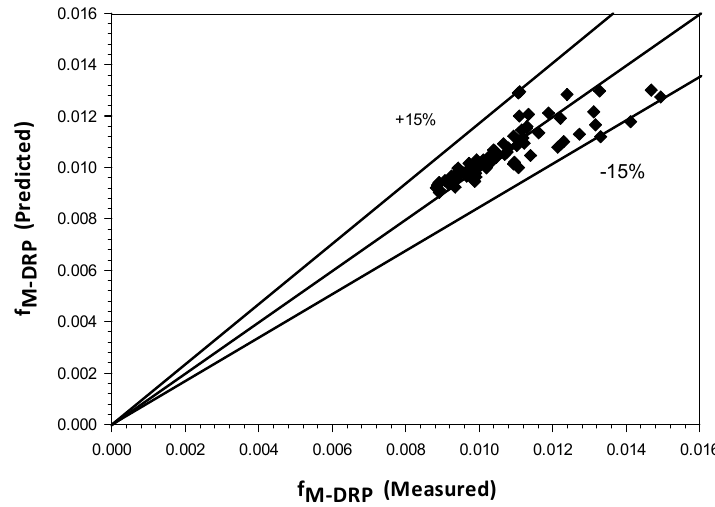
Figure 17. Comparison between measured friction factor and predicted by Equation (7).